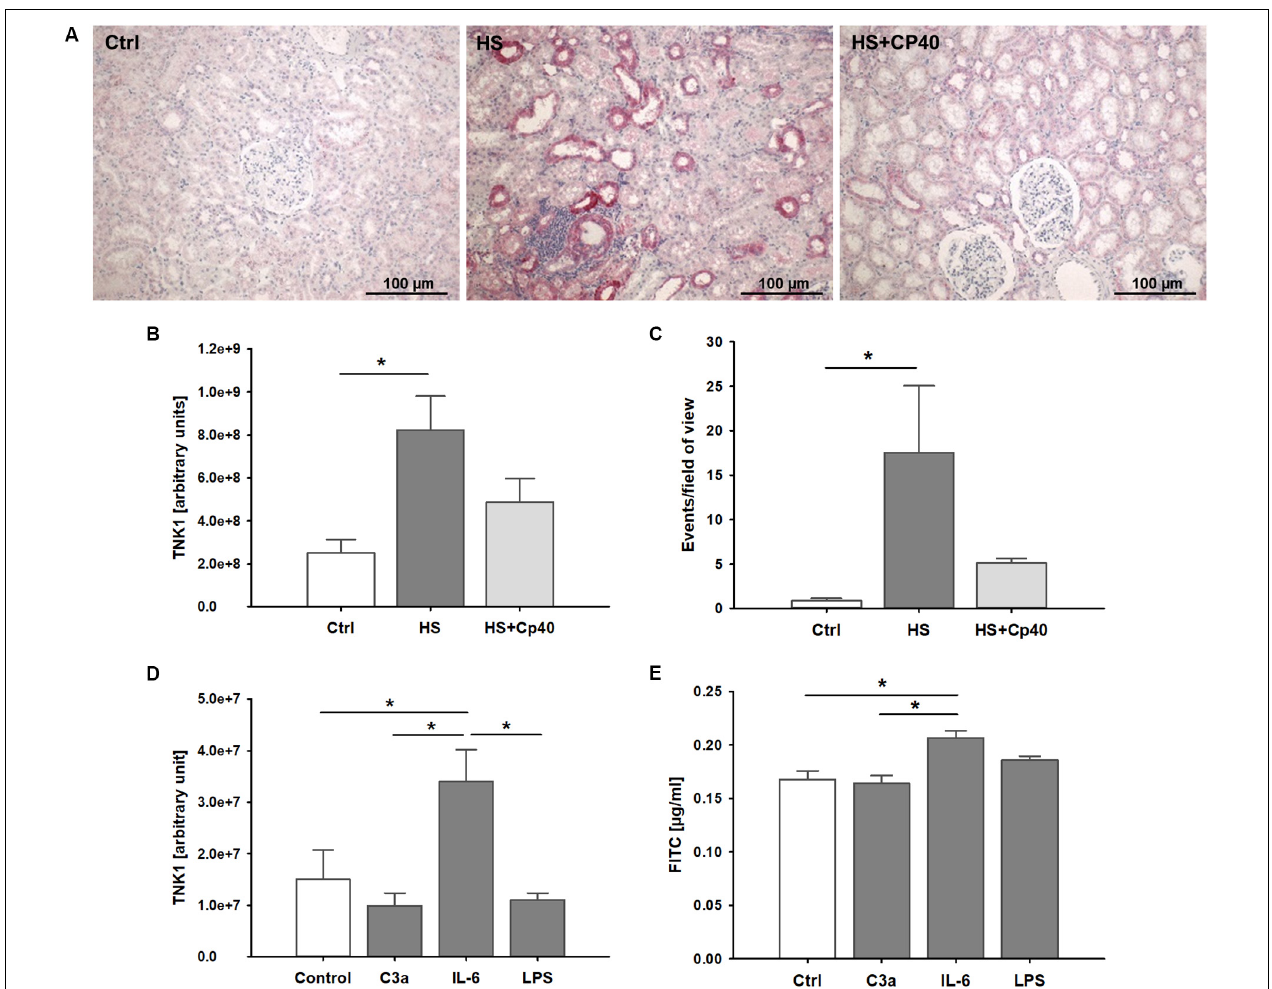
FIGURE 4 | Role of non-receptor tyrosine-protein kinase 1 (TNK1) in hemorrhage-induced kidney injury. TNK1 expression and cellular apoptosis were analyzed in kidneys from non-human primates (A–C) . (A) TNK1 was stained by immunohistochemistry (TNK1 staining in red; nuclei were counterstained with hematoxylin) in non-human primate kidneys after hemorrhagic shock with placebo treatment (HS) or HS and treatment with the complement inhibitor Cp40 (HS + Cp40) as well as in healthy control animals (Ctrl). Quantification of stained tissues revealed a significant increase in TNK1 expression in HS animals compared to controls which was abolished by Cp40 treatment (B) . A TUNEL assay showed similar results with a significant increase in apoptotic events in kidneys after hemorrhage which was prevented by complement blockade using Cp40 (C) ; * p < 0.05, n = 3 Ctrl, n = 4 HS, n = 4 HS + Cp40 for (B,C) . In murine distal convoluted tubule cells (D,E) , TNK1 expression was significantly increased after stimulation with interleukin 6 (IL-6), but not altered after incubation with activated complement component 3 (C3a), or lipopolysaccharide (LPS, D ). Cellular permeability for 4 kDa FITC-labeled dextran in a transwell chamber was significantly increased after stimulation with IL-6, but not with C3a or LPS (E) . The data in (D) and (E) are representative of two independent experiments. * p < 0.05, n = 5 for (D,E)